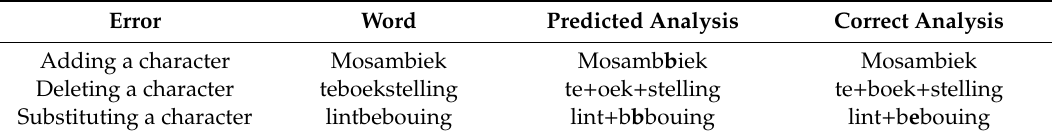
Table 8. Examples of erroneous analyses made by the neural compound analysis model.